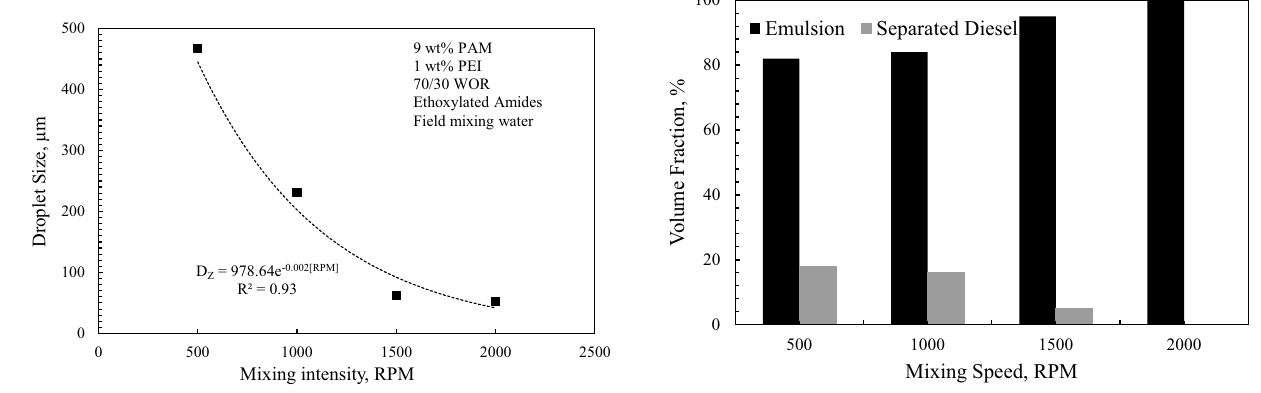
Fig. 3 Volume fraction of the emulsified gels at different mixing speeds after 1 week at 25